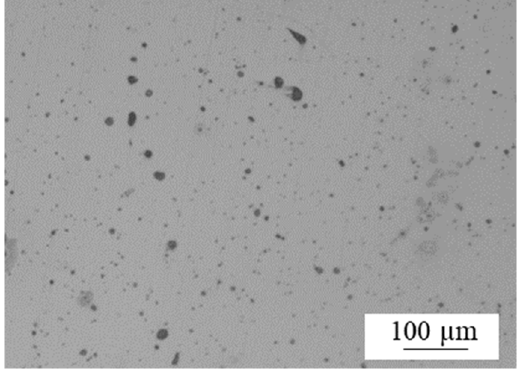
Figure 10. Micropores in the BMD manufactured parts.